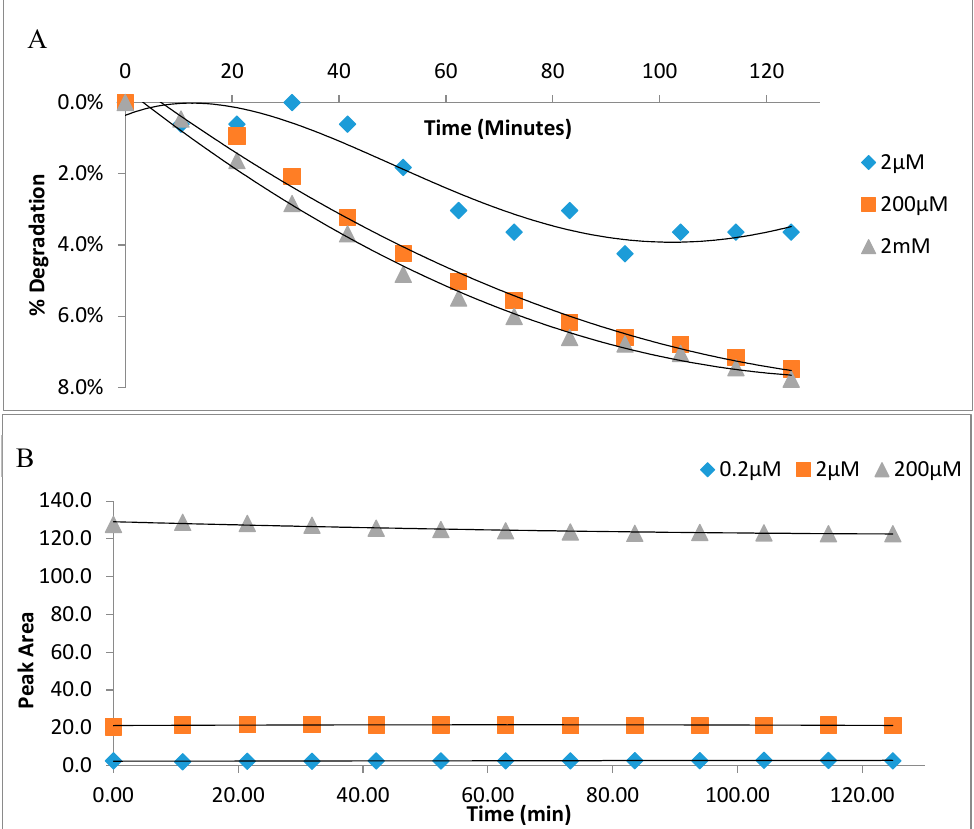
Figure 8. ( A , B ): Stability of glutathione-OPA adduct. The time-dependent (over 120 min) degradation at 40 ◦ C of reduced glutathione (GSH) ( A ) and oxidised glutathione (GSSG) ( B ) after derivatisation at three concentrations: 2 µ m, 200 µ m and 2 mM ( A ). Data are presented as means ( n =